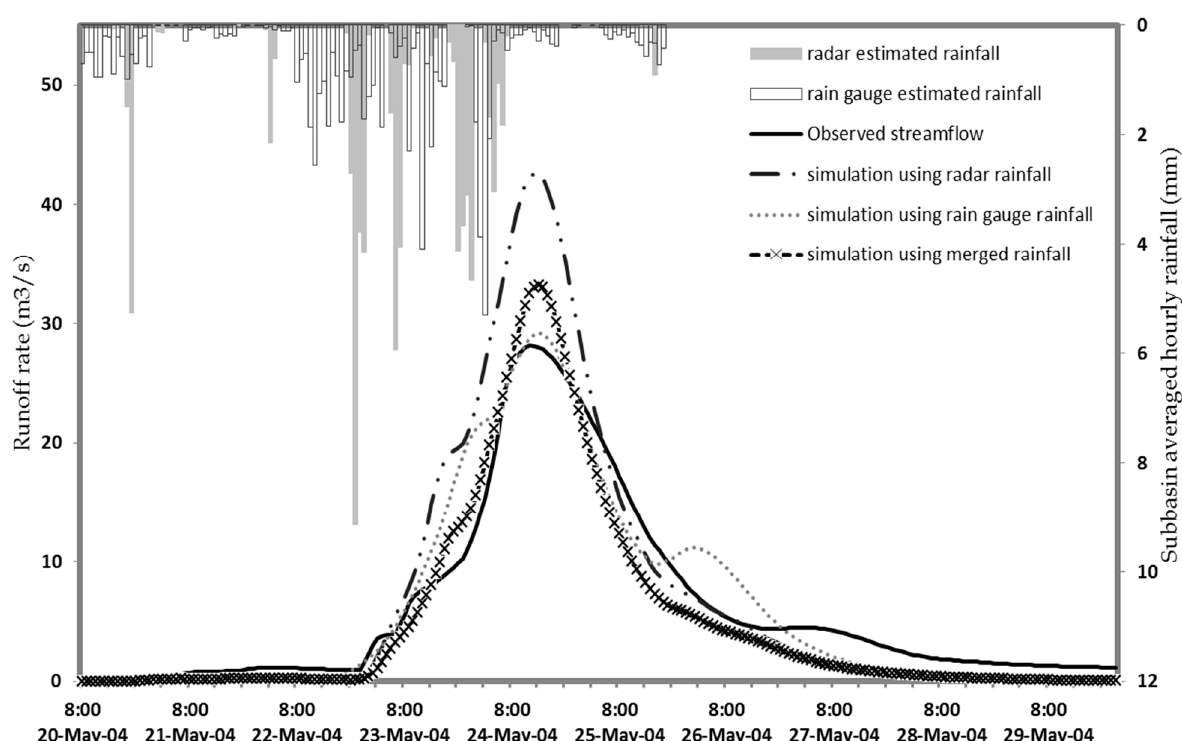
Figure 16. Comparison of estimated and observed hydrographs using different rainfall estimates for the 2 November 2003 event with SCS modeling option.